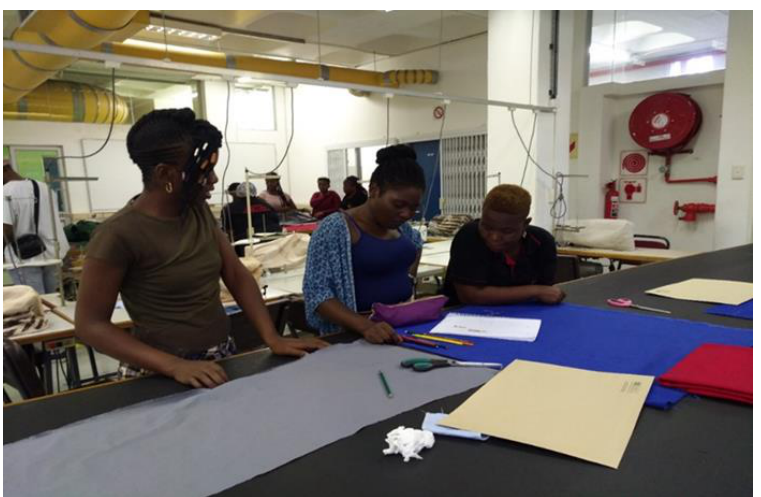
Figure 1 : Fashion students and Thusa Batho woman discussing and laying out fabric before cutting and sewing the garment at the DUT Fashion department campus. Photograph taken by K.